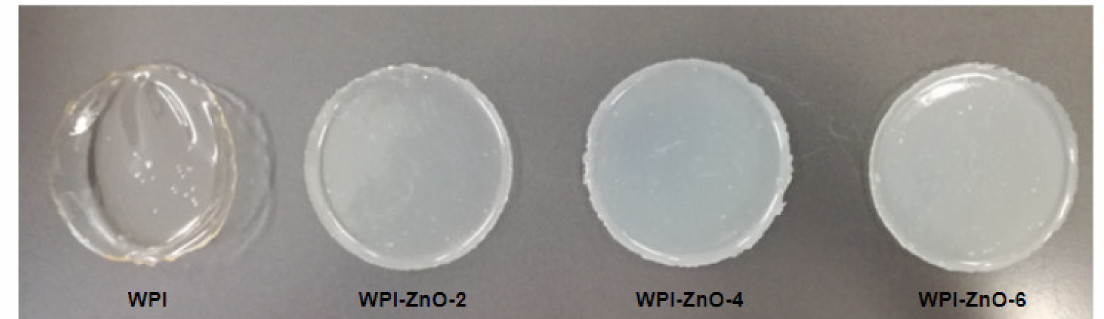
Figure 5. WPI films with increasing n-ZnO concentrations.